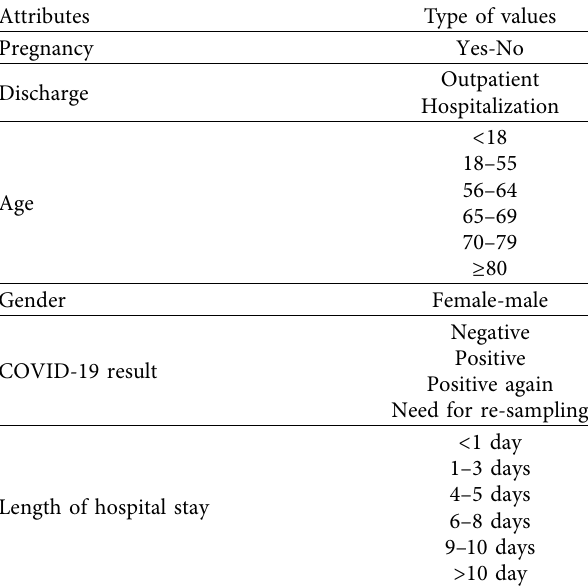
Table 2: Lists of the other attributes and their different values.